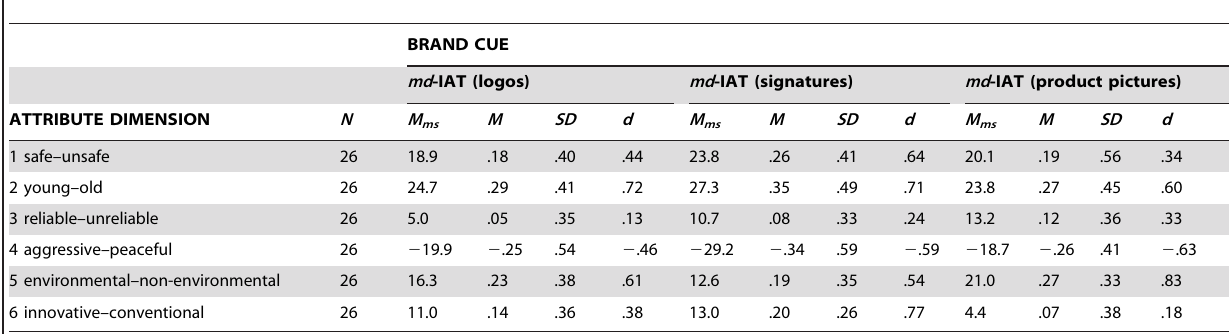
Table 6. Study 2: Summary of all 18 single IATs with factors ATTRIBUTE DIMENSION and BRAND CUE (6 6 3).